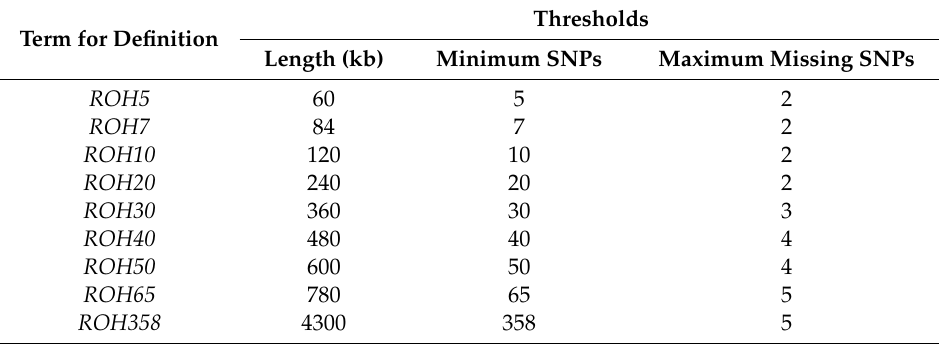
Table 1. Overview of the di ff erent definitions of runs of homozygosity (ROHs) in this study. Thresholds Term for Definition Length (kb) Minimum SNPs Maximum Missing